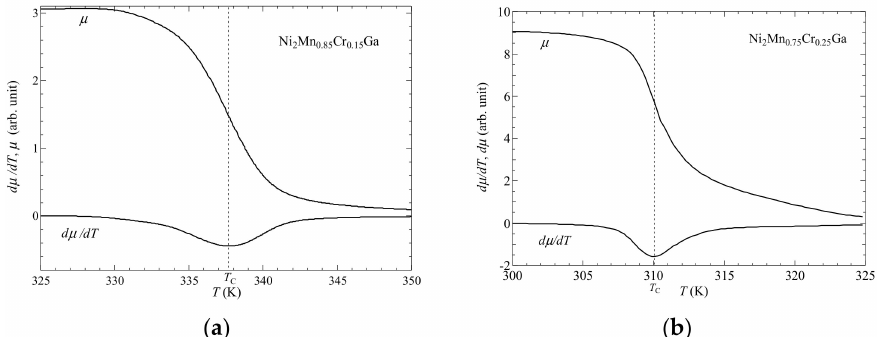
Figure 1. Permeability µ and d µ / dT for ( a ) x = 0.15 and ( b ) x = 0.25 near T C . Data from Ref. [27]. T. Sakon, et al. Metals 2017 , 7 , 410. MDPI, doi:10.3390 /